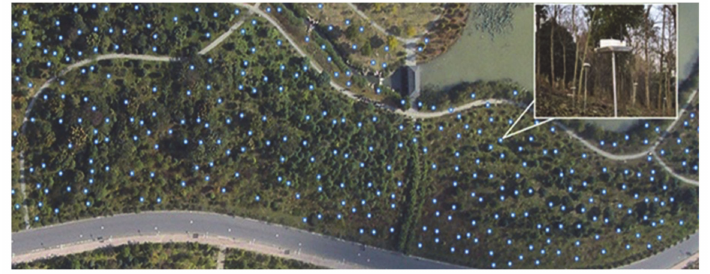
Figure 4. Wireless sensor nodes in GreenOrbs